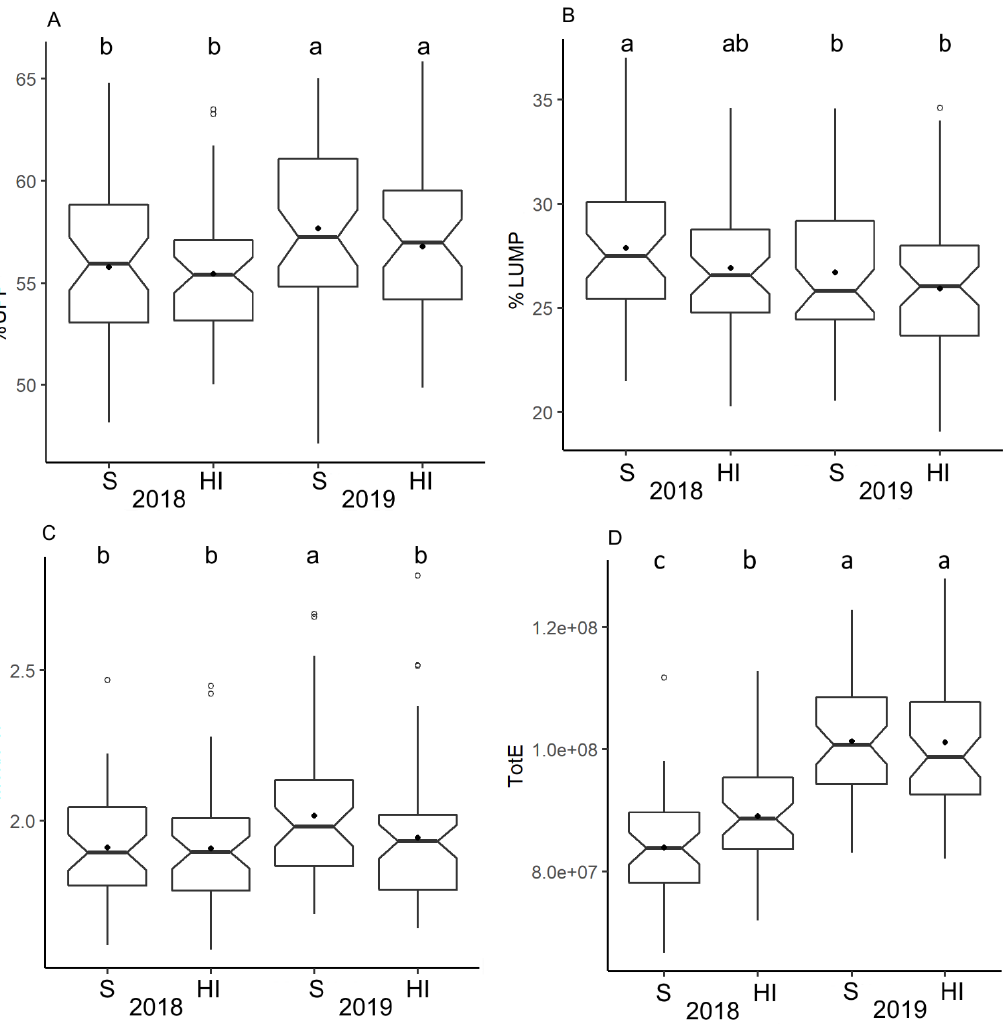
Figure 5. Gluten protein parameters of winter wheat studied in varying climates (heat and drought- heat) and nitrogen regimes of sustainable (S) and high-input (HI) trials in 2018–2019 investigated by SE-HPLC; unextractable polymeric protein (%UPP) ( A ); % large unextractable monomeric protein (%LUMP) ( B ); total monomer to total polymer ratio (Mon/Pol) ( C ); and total extractable protein content (TotE) ( D ). Means followed by the same letters are not significantly different ( p < 0.05, Tukey HSD test, n = 50).